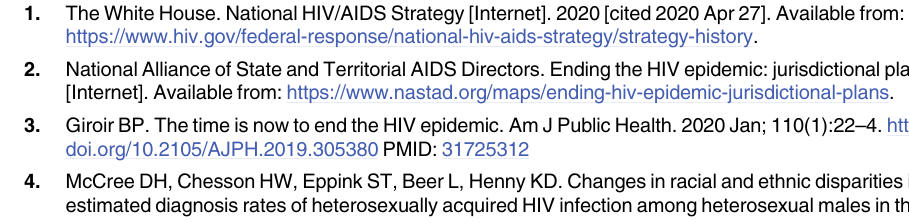
S1 Table. Survey questions used to determine recent heterosexual activity. S2 Table. State-level estimates of heterosexually active Men and Women Ages 18+ and HIV diagnosis